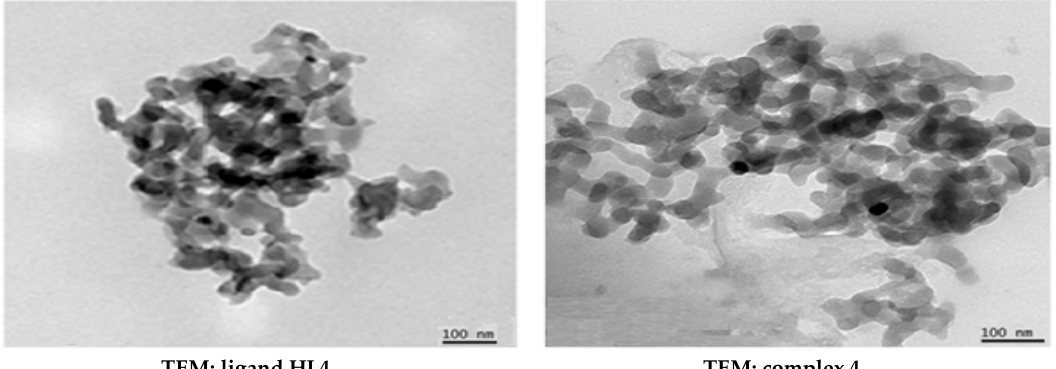
Figure 1. The SEM and TEM images of ligand HL4 and the corresponding immobilized complex 4 showing different morphologies.